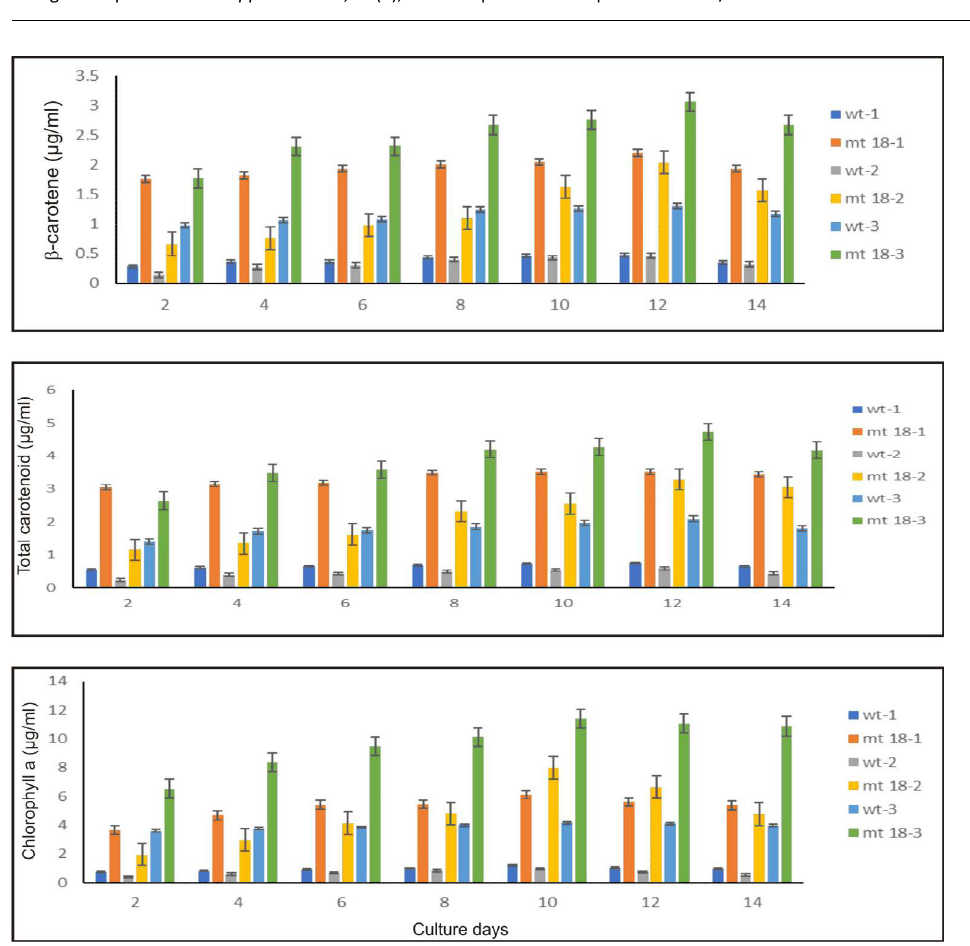
Fig. 7 . Pigment of wild type and KU18 mutant strain in the first cultivation cycle (wt-1, st18-1), the second cultivation cycle (wt-2, st18-2) and the third cultivation cycle (wt-3, st18-3) in 2.5M NaCl modified Jonson’s medium under 200 mmol photons m -2 ·s -1